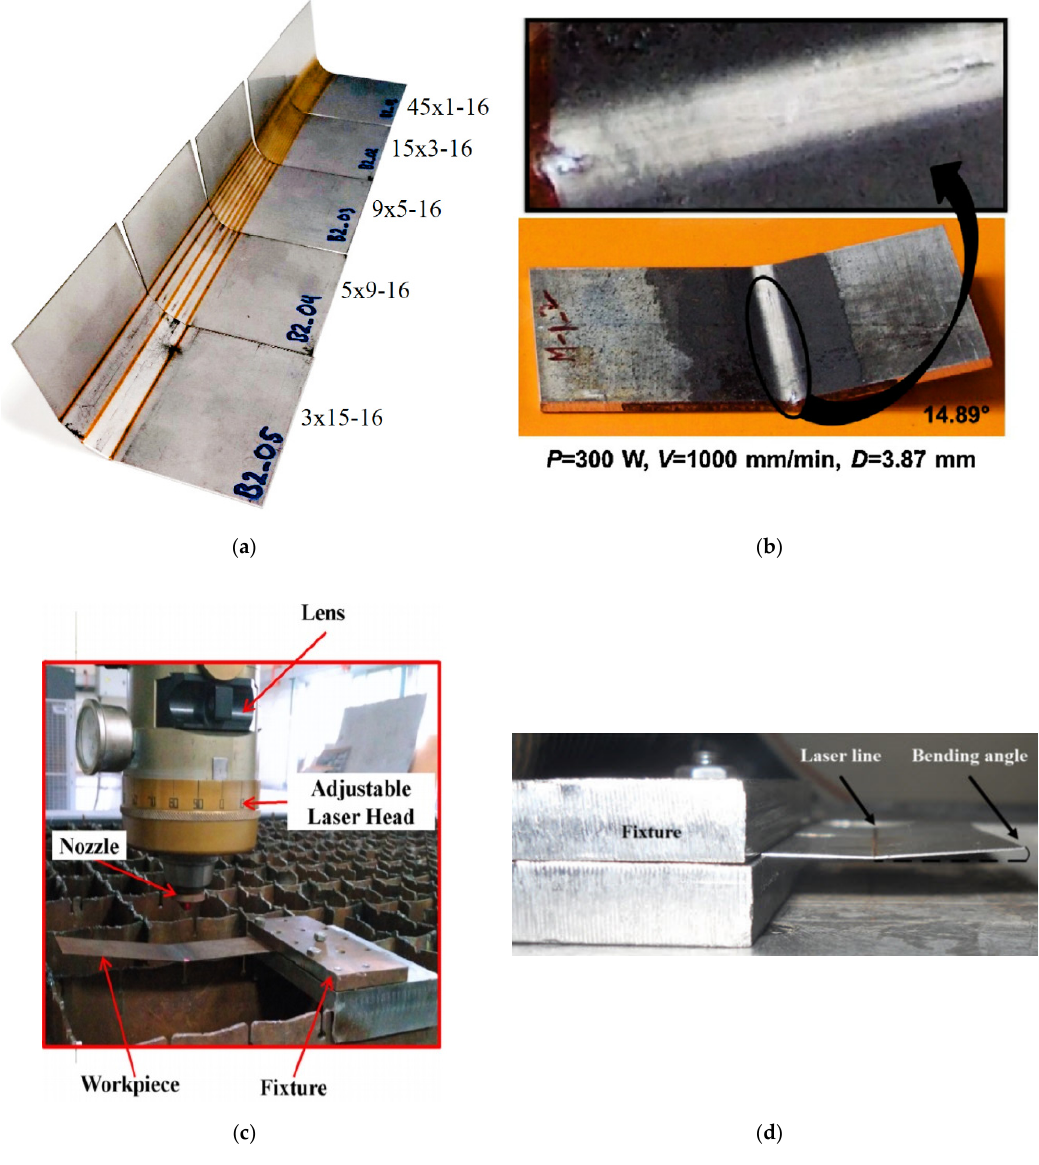
Figure 1. ( a ) Bending of the sheet by multi-pass irradiation [12], (Adapted from [12], with permission from Elsevier, 2020). ( b ) laser bending by multi-scan laser bending [22], (Adapted from [22], with permission from Elsevier, 2020). ( c ) Laser bending of AH36 steel [18], (Adapted from [18], with permission from Elsevier, 2020). ( d ) laser forming of AISI 304-stainless steel sheet with surface roughness and Cr 2 O 3 oxide layer created [7], (Adapted from [7], with permission from Elsevier, 2020).